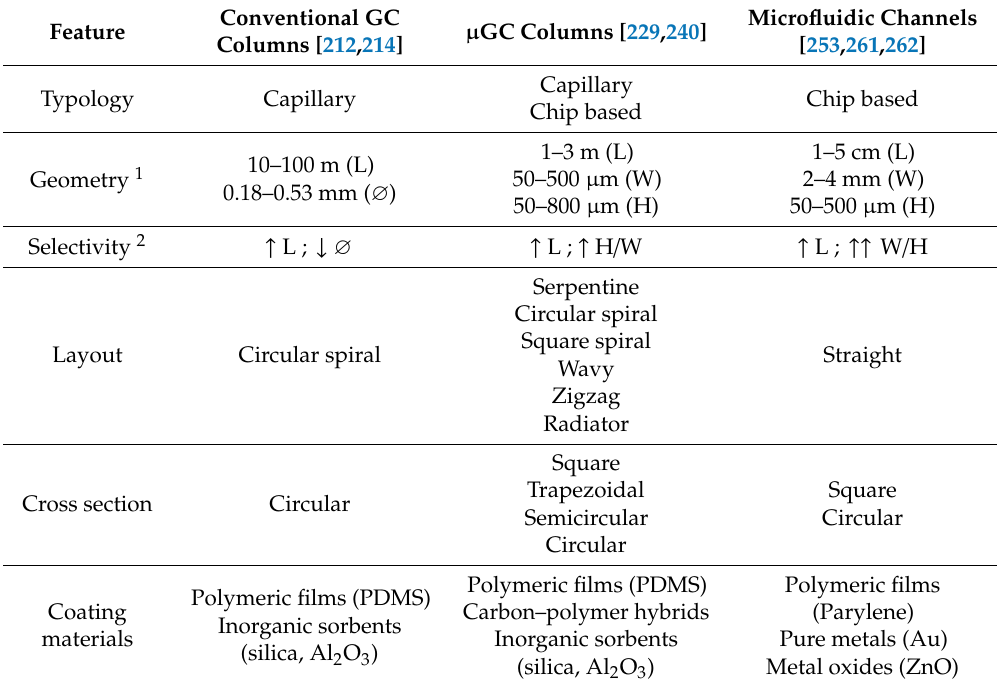
Table 2. Comparative analysis of macro- and microanalytical tools for the separation of